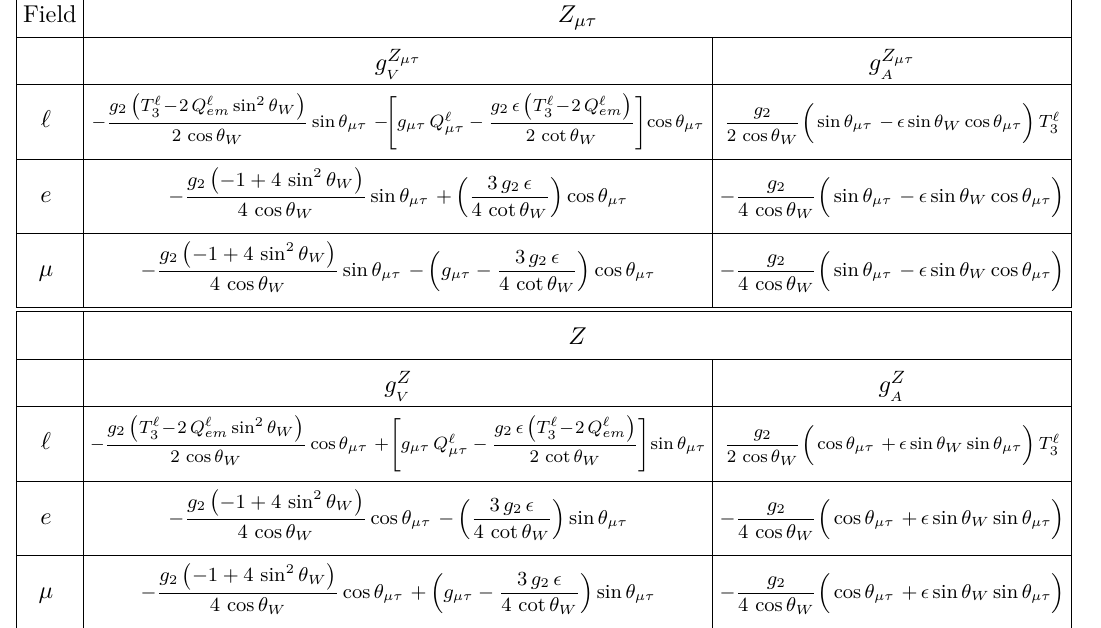
Table 1 . ‘‘Z µτ ( Z ) vertex factors for a general lepton ‘ with third component of weak isospin T ‘ electric charge Q ‘